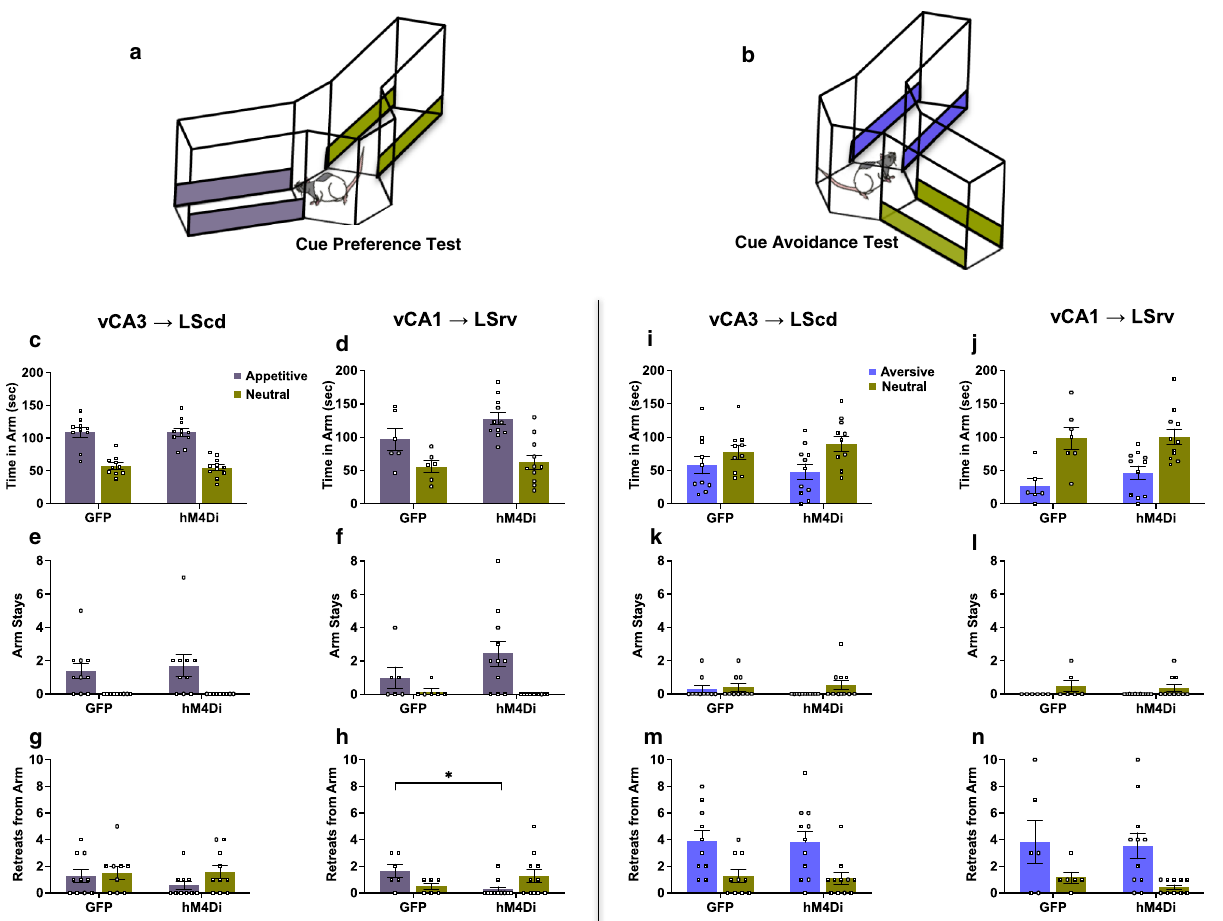
Fig. 4 Chemogenetic inhibition of vHPC-LS pathways does not affect conditioned cue preference or avoidance tests. a , b Diagrams show the con fi guration of a cue preference test in which animals were allowed to freely explore an arm imbued with appetitive cues (grey bars), and an arm with neutral cues (green bars), and cue avoidance test in which animals were presented with an arm with aversive cues (blue bars) and another arm with neutral cues (green bars). c , d Regardless of pathway targeted or virus type, animals spent more time in the appetitive arm than the neutral arm (vCA3 Arm: F (1,19) = 88.56, p = 0.0001; vCA1 Arm: F (1,15) = 16.22, p = 0.0011; vCA1 Arm x Virus: F (1,15) = 0.85, p = 0.3709), e , f and emitted arm stays